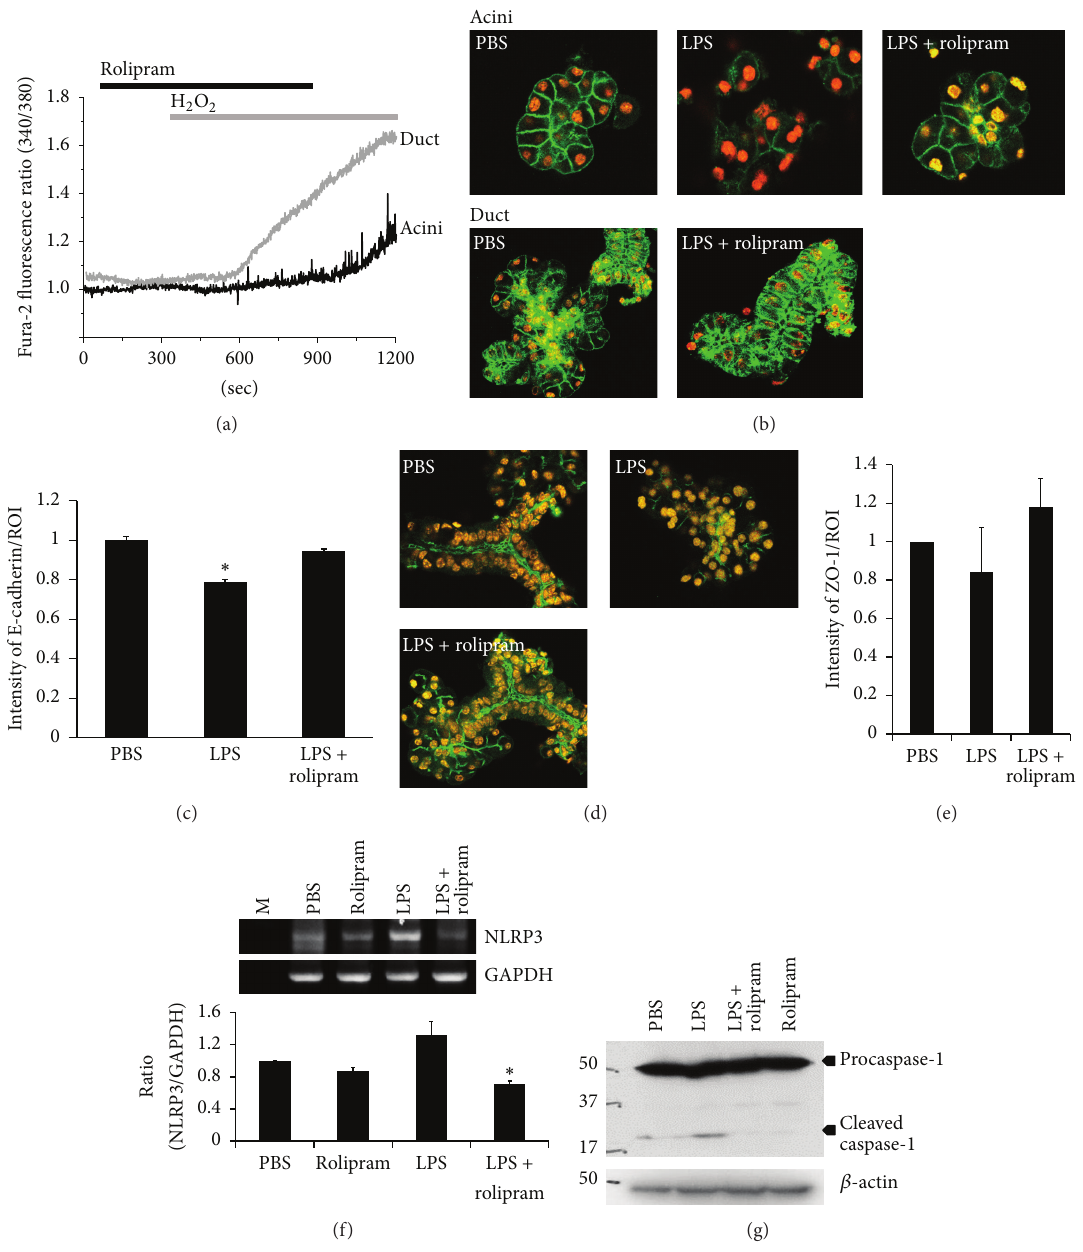
Figure 3: Differential role of rolipram in SMG acinar and ductal cells. (a) Changes in [ Ca 2+ ] i induced by 10 𝜇 M H 2 O 2 and pretreatment with 10 𝜇 g/mL rolipram in acinar (black trace) and ductal cells (gray trace). (b) Immunofluorescence staining patterns of E-cadherin protein (green) and DAPI staining (orange) of SMG acinar and ductal cells. The isolated SMG cells were treated with LPS in the absence or presence of rolipram for 1hr. (c) Relative intensity of E-cadherin in plasma membrane (PM) fraction divided by the region of interest (ROI). The bars show the mean ± SEM ( 𝑛 = 3 ). (d) Immunofluorescence staining patterns of ZO-1 protein (green) and DAPI staining (orange) of SMG acinar and ductal clusters indicated experimental condition. (e) Relative intensity of ZO-1 divided by ROI. The bars show the mean ± SEM ( 𝑛 = 3 ). (f) mRNA expression of NLRP3 after the indicated stimulation for 30 min. Ratios are expressed as ratio of control and means ± SEMs are shown ( 𝑛 = 3 , ∗ 𝑃 < 0.01 ) compared with PBS. (g) Western blot analysis with caspase-1 after stimulation of indicated condition for